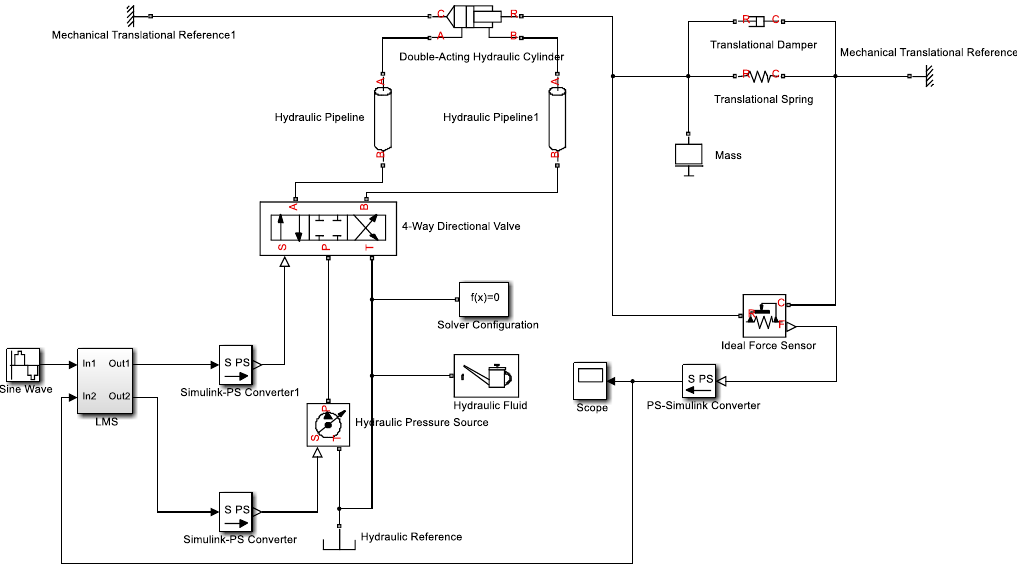
Figure 6. Simulation model of testing machine.